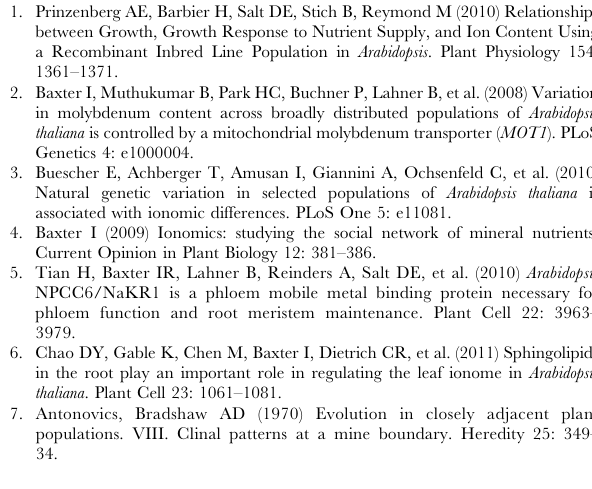
Table S1 Ionomic traits with significant cytoplasmic effects in the RILs after Bonferroni correction.